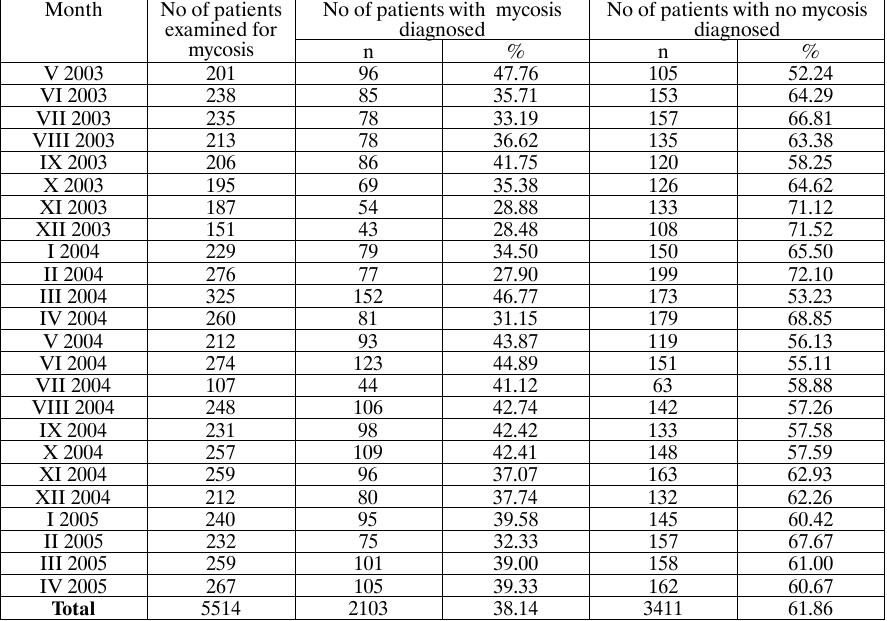
Patients presenting with suspected mycosis between 01 May 2003 and 30 April